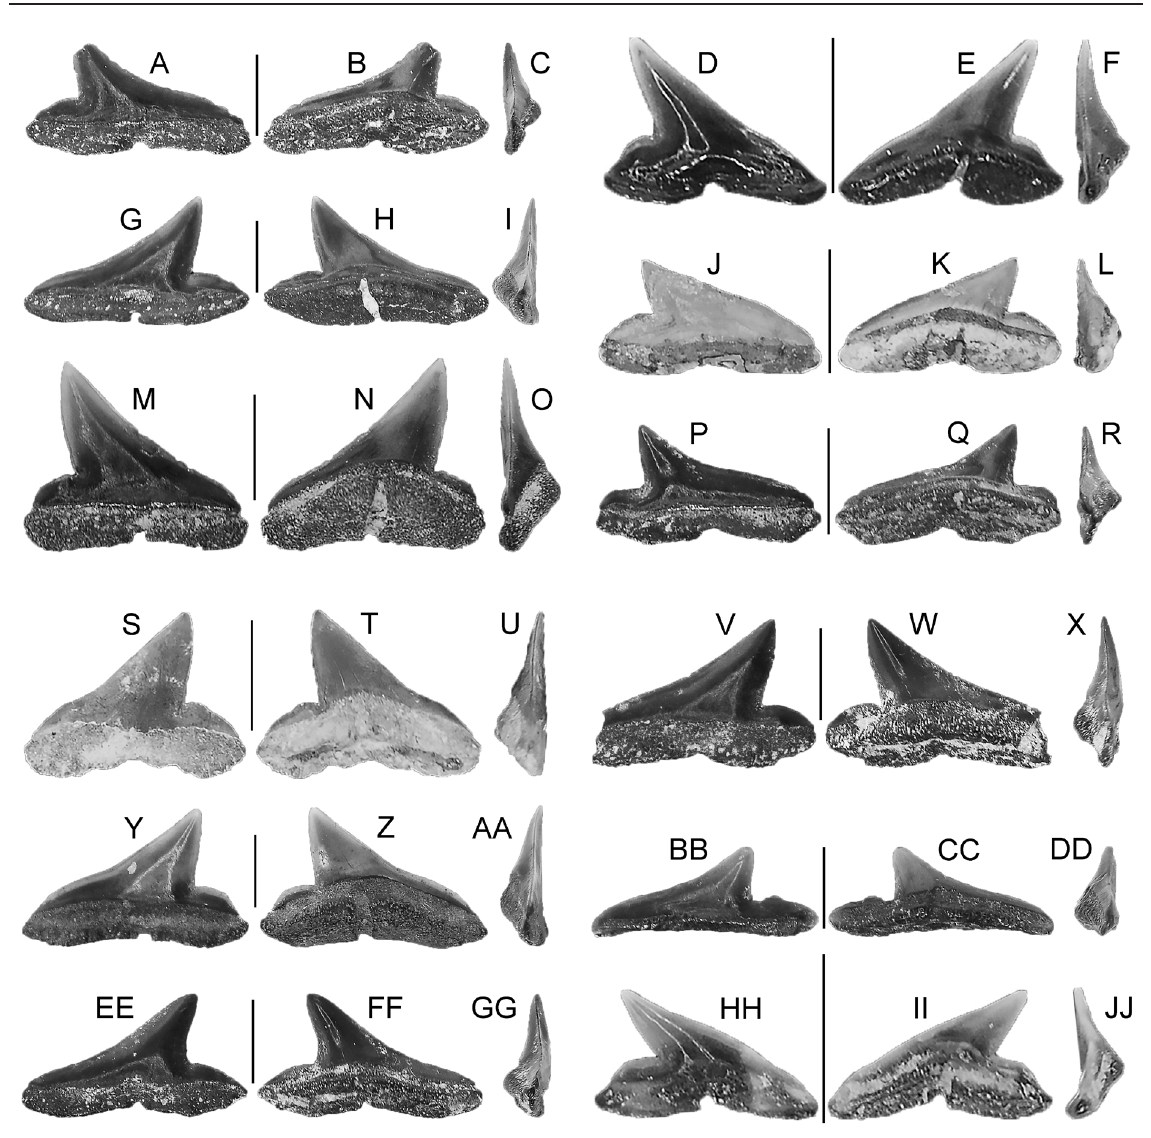
Fig. 28. Rhizoprionodon ganntourensis (Arambourg, 1952), teeth. A–C . MSC 2173.4,